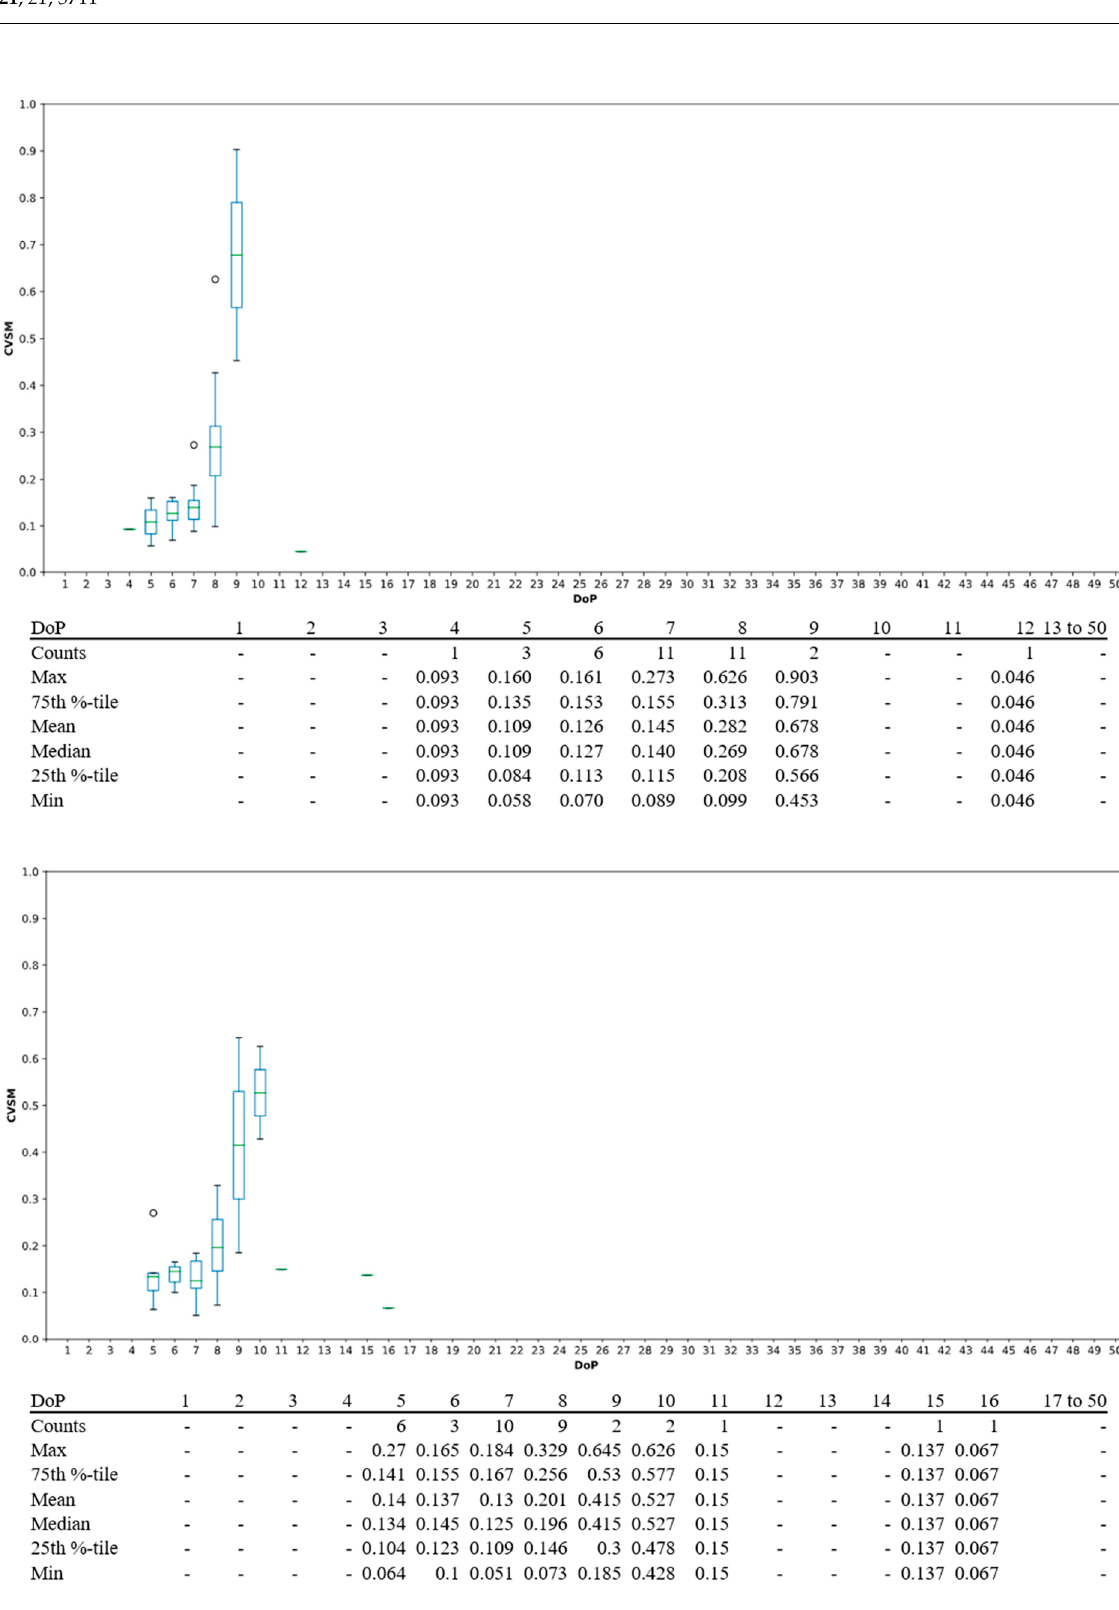
Figure 6. CVSM spread per DoP for PJ datasets. Left wrist ( top ) and right wrist ( bottom ).